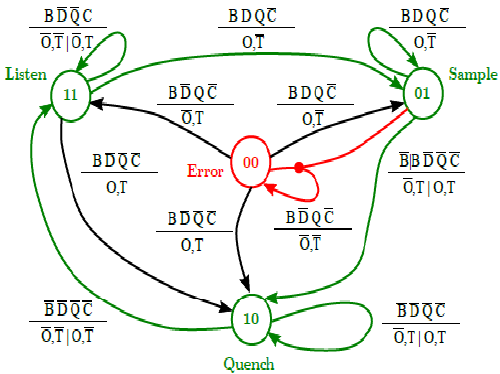
Figure 13. State diagram for quench control with inputs T , O and outputs B , D , Q , C . Normal operation is marked green. The error state indicates cut-off during sampling phase at the end of an input bit (red).